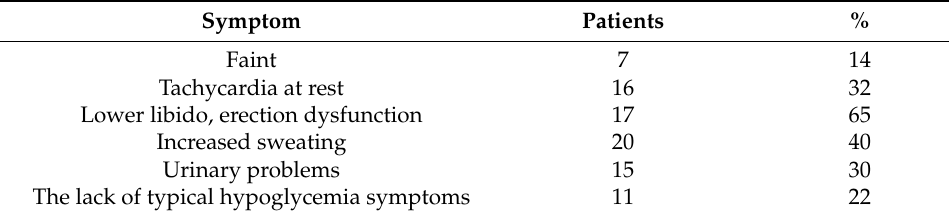
Table 4. Diabetic autonomic neuropathy symptoms.